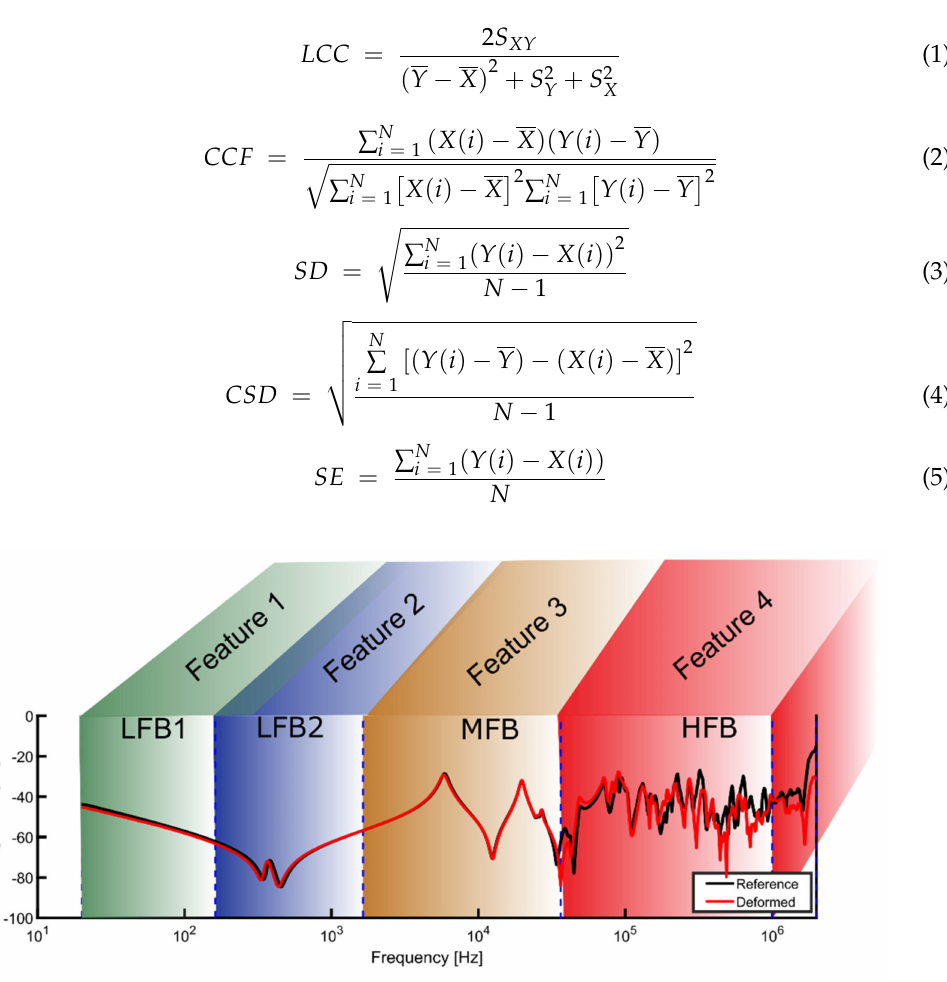
Figure 15. An example of feature generation from four frequency sub-bands of magnitude plot of